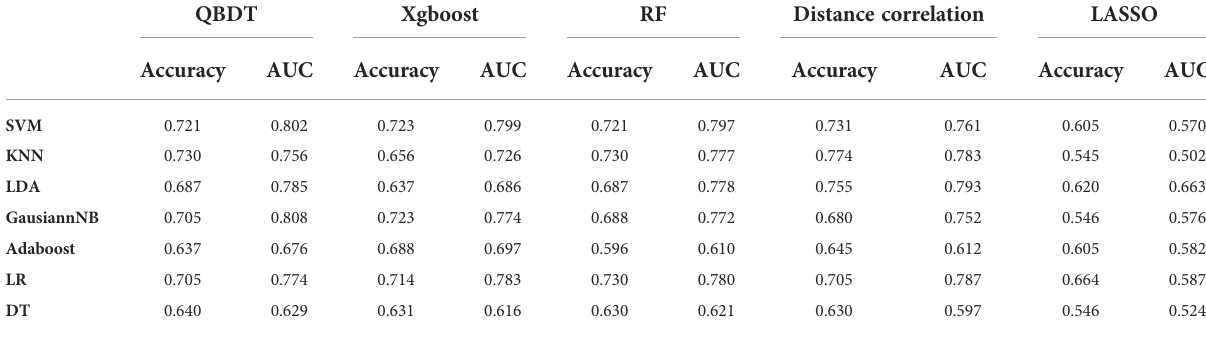
TABLE 5 Results of discriminative CMs in group 2 in the testing group.